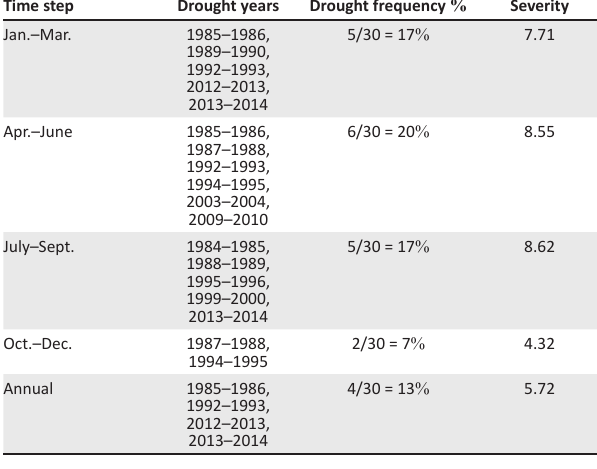
TABLE 4: Drought analysis in terms of frequency and severity over the 1984– 2014 period with standardised precipitation index < -1.